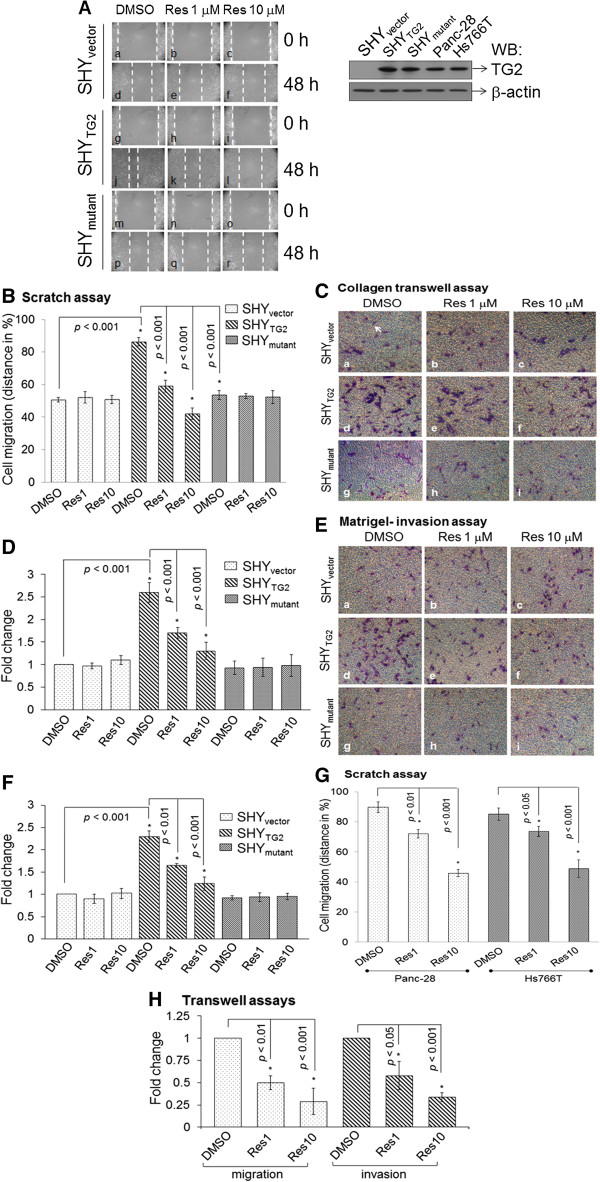
Cell migration and invasion assays. (A) Representative images from the scratch assays showing the migration of SHYvector, SHYTG2, and SHYmutant cells. Mytomycin C treated cells were preincubated with resveratrol (1 μM and 10 μM) for 24 h; a scratch was made and further incubated with resveratrol. At 0 h and 48 h after scratch, cells were photographed. Dotted lines represent the edge of migrated cells in the scratch. Upper right panel: Western blot for TG2 protein using 10 μg total cell extract from SHYvector, SHYTG2, SHYmutant, Panc-28, and Hs766T cells. (B) The distance covered by cells in the original empty area was measured and plotted in %. Bars represent mean ± SD of three independent experiments. *p value < 0.05. (C-E) Images from collagen-transwell and matrigel-transwell assays. After 48 h with or without resveratrol treatment, cells were trypsinized and seeded on collagen-transwell (C) or matrigel-transwell inserts in the presence of resveratrol (E). After 15 h, migrated cells on the lower side of inserts were stained with Hema-3 stain (arrow), counted from ten random fields and plotted (D and F). Bars are mean ± SD of at least three independent experiments and *p value < 0.05. (G) Bar diagram represents the migration of Panc-28 and Hs766T cells in scratch assays in the presence of resveratrol as performed with SH-SY5Y cells. Migrated cells into the original empty area were photographed and plotted. Bars are mean ± SD of three independent experiments. *p value < 0.05. (H) Migration and invasion assays for Panc-28 cells were carried out as with neuroblastoma cells in transwell inserts. Migrated/invaded cells were counted from 10 random fields and plotted. Bars are mean ± SD of three independent experiments. *p value < 0.05.